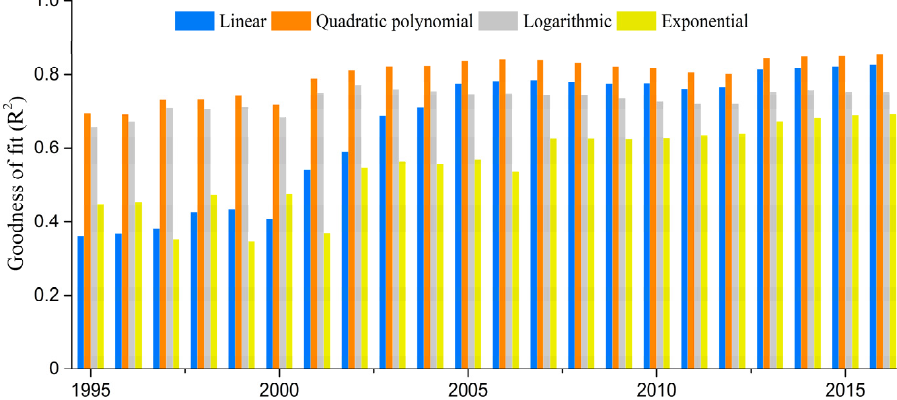
Figure 2. Goodness of fit of energy consumption and the total digital number values (TDN) of nighttime light data in China.